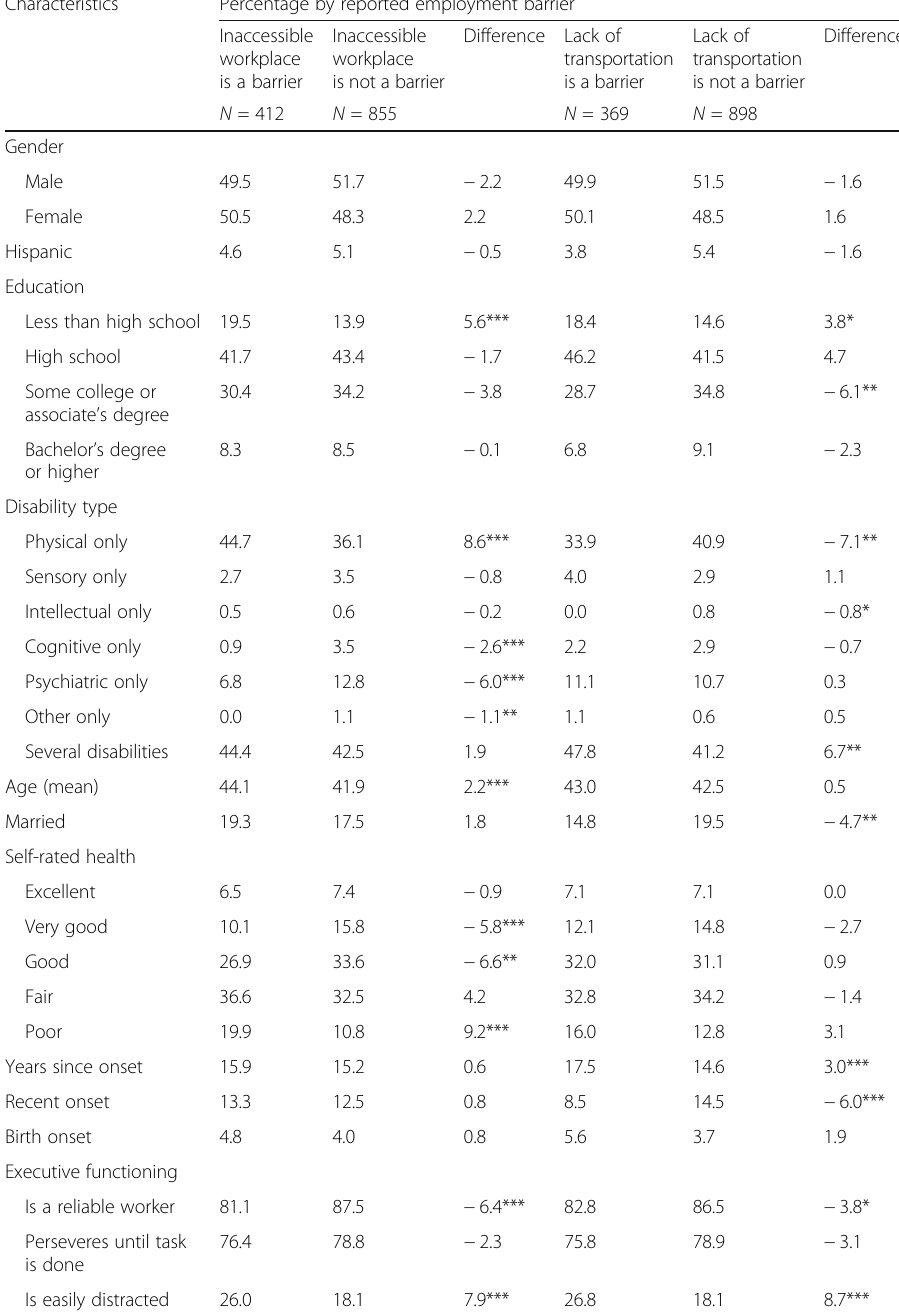
Table 6 Individual characteristics by employment barriers reported for those who are not working